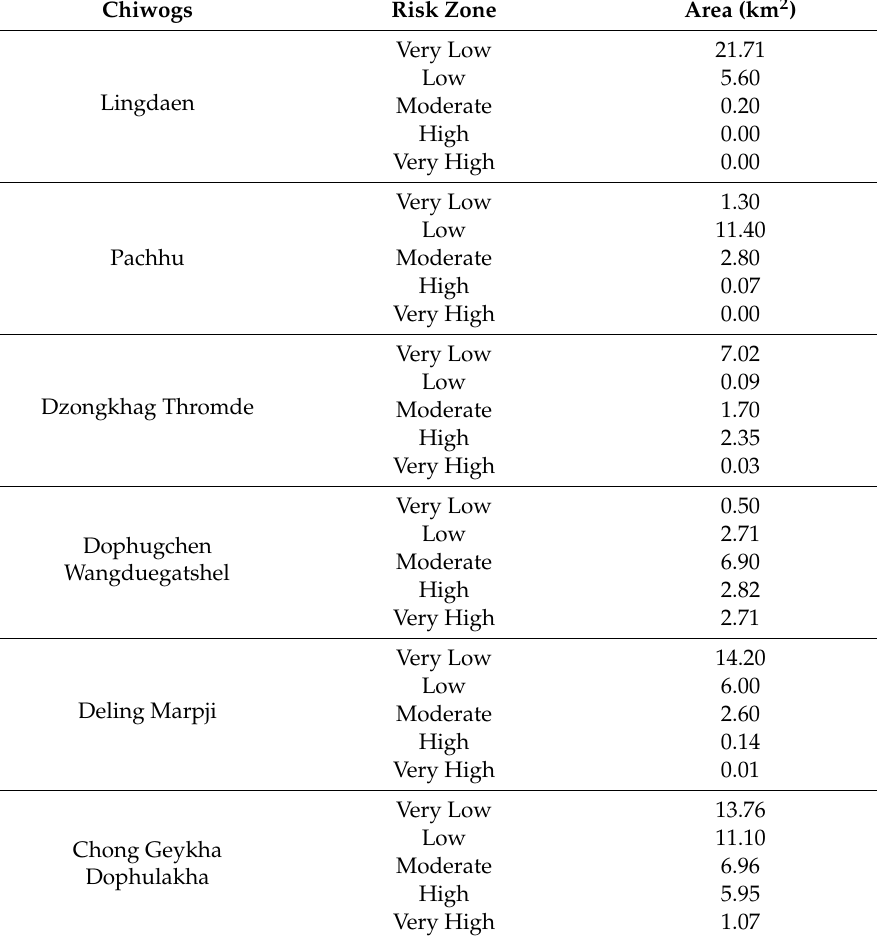
Table 3. Area affected by various risk zones for all six chiwogs.